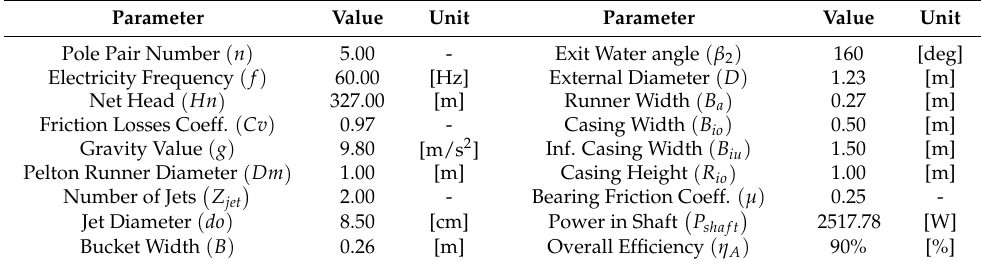
Table 3. Main dimensions and parameters of Illuchi N2 power plant.